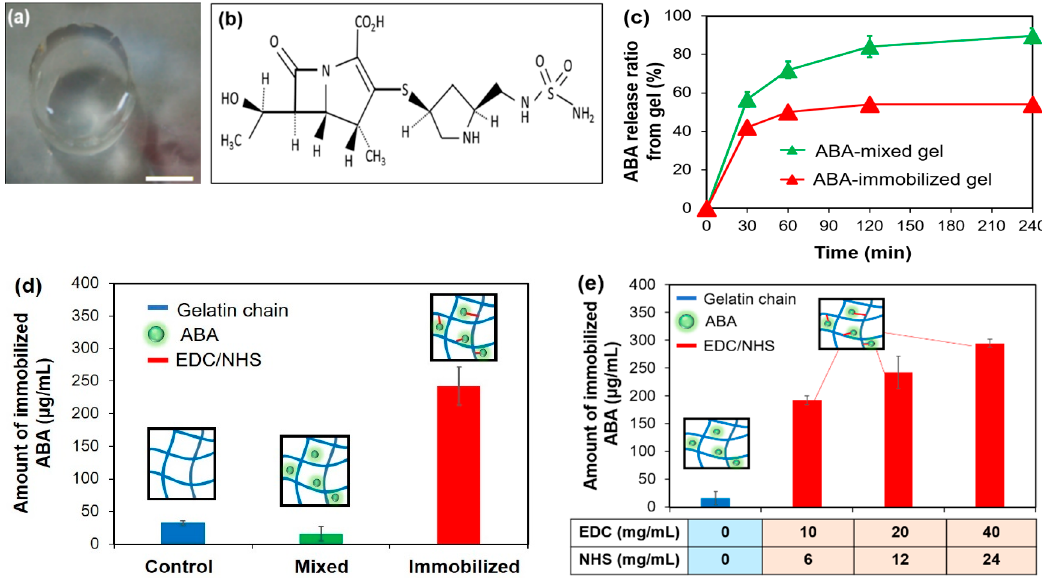
Figure 2. ( a ) Photograph of the ABA-Gelatin gel- the bar represents 5 mm; ( b ) the molecular structure of Finibax as an ABA; ( c ) the release percent of ABA in the gels; ( d ) the immobilized ABA amount in the ABA-free, ABA-mixed, and ABA-immobilized gelatins; and ( e ) the immobilized ABA amount at different concentrations of the crosslinking agent.